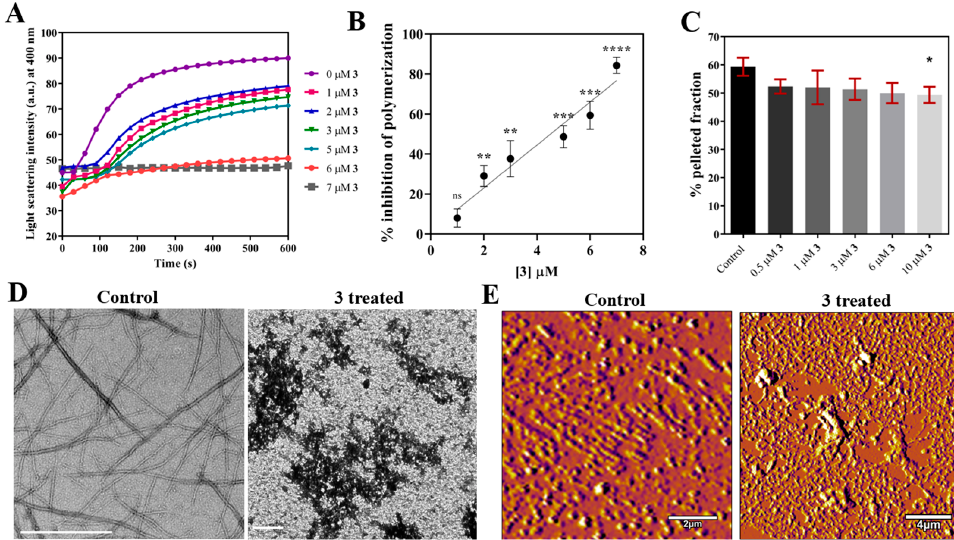
Figure 7. Compound 3 inhibits FtsZ polymerization and induces FtsZ aggregation. ( A ) Spn FtsZ (10 µM) in 50 mM PIPES pH 7.4, 50 mM KCl and 5 mM MgCl 2 (PKM) buffer was incubated with different concentrations of 3 for 20 min at 25 °C polymerized in the presence of 1 mM GTP. The polymerization was monitored using light scattering with emission and excitation wavelength set to 400 nm. ( B ) The change in the extent of light scattering representing Spn FtsZ polymerization in the presence of 3 was plotted as percentage inhibition Vs concentration of 3 . The error bars indicate standard